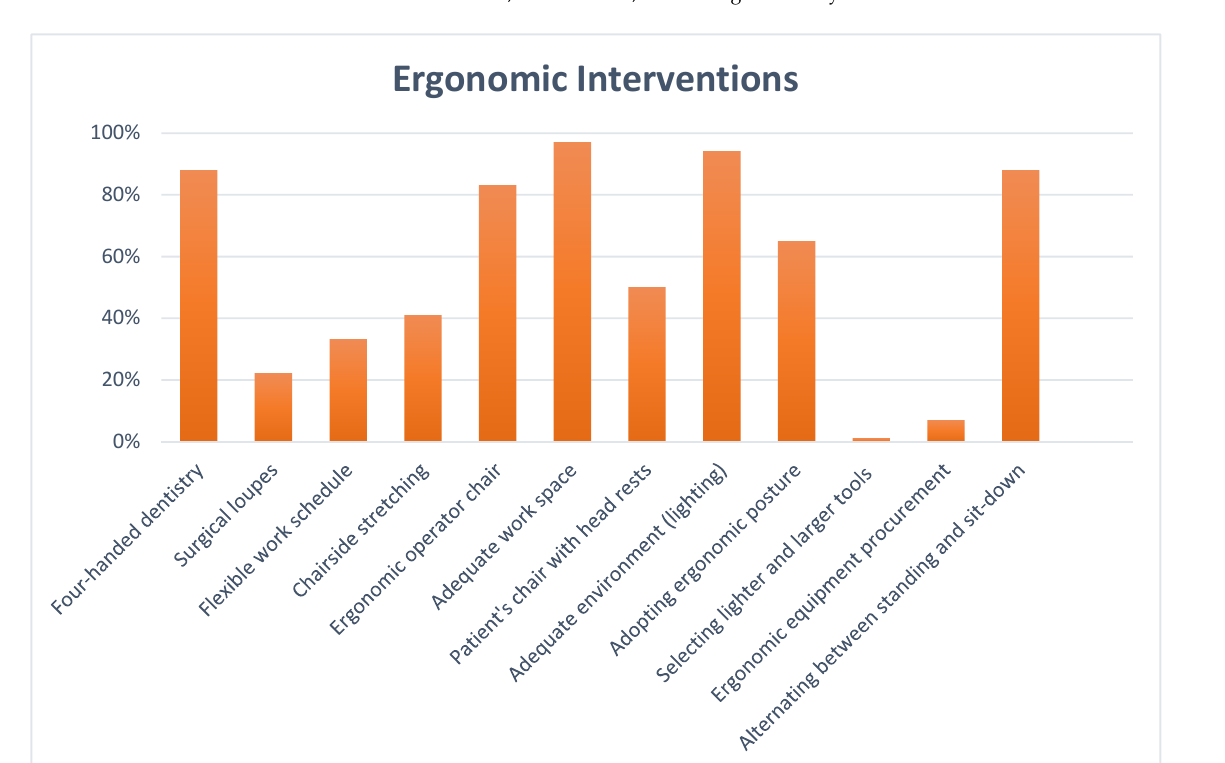
Figure 2. Bar chart showing dental staff checklist